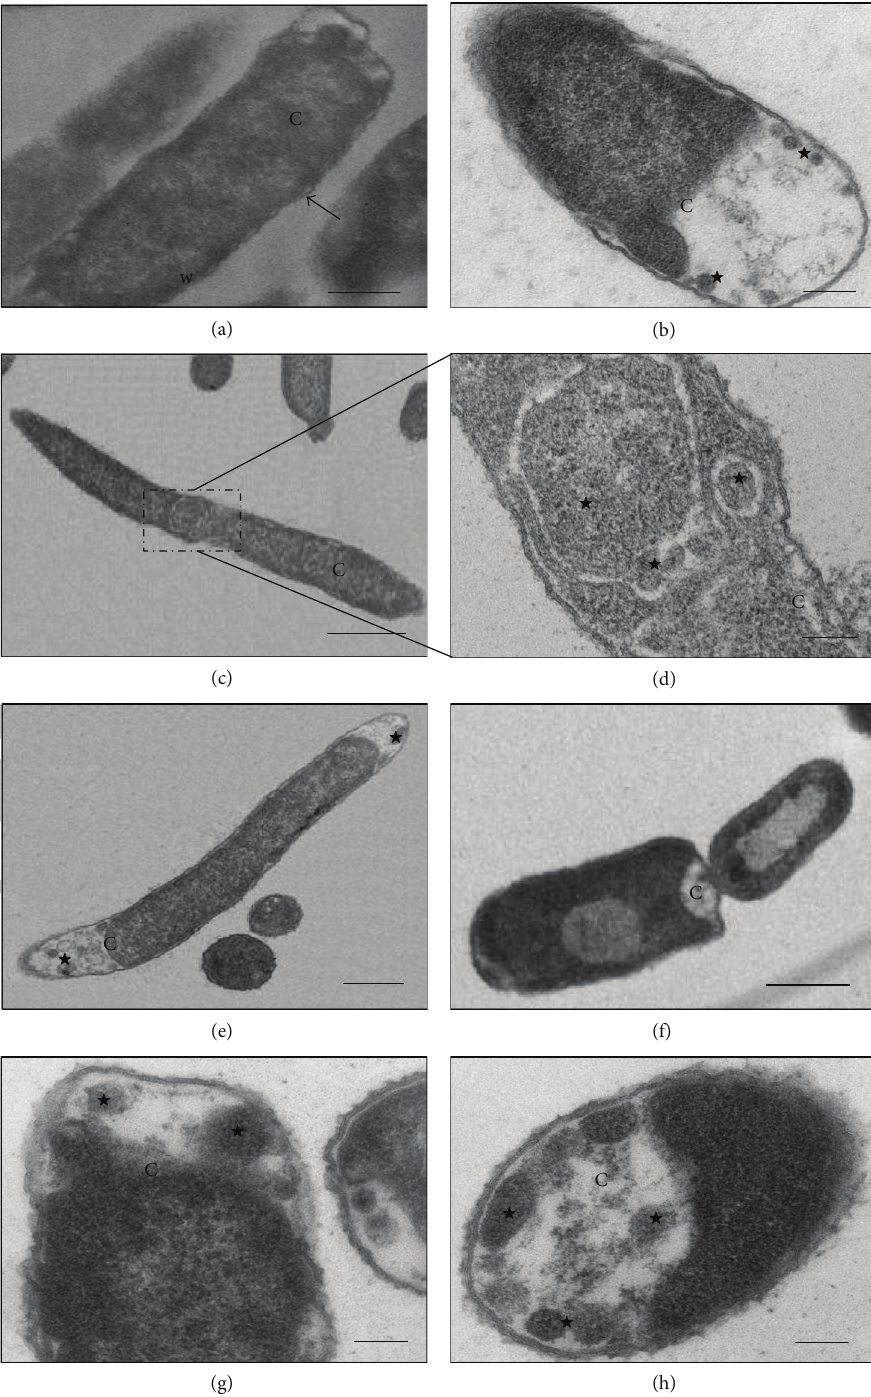
Figure 2: (a–h) Transmission electron micrographs of isolate K16R from K. pneumoniae . (a) Untreated bacterial cell—preserved morphology, cytoplasmic membrane (arrow), cell wall (w), and cytoplasm (C) intact. (b) Cell subjected to CTX (64 𝜇 g mL −1 )—presence of large electron- lucent space due to increased periplasmic space (stars) and reduced cytoplasmic material (C). (c–e) Cells subjected to CAZ (16 𝜇 g mL −1 ). (c-d) Filamentous cells and the presence of membrane compartments containing cytoplasmic material (star). (e) Elongated cell showing loss of cytoplasmic material (star). (f–h) Cell subjected to ATM (4 𝜇 g mL −1 )—loss of cytoplasmic material (C) and presence of membrane compartments (stars). Bars = 0.5 𝜇 m. CAZ: ceftazidime; CTX: cefotaxime; and ATM: